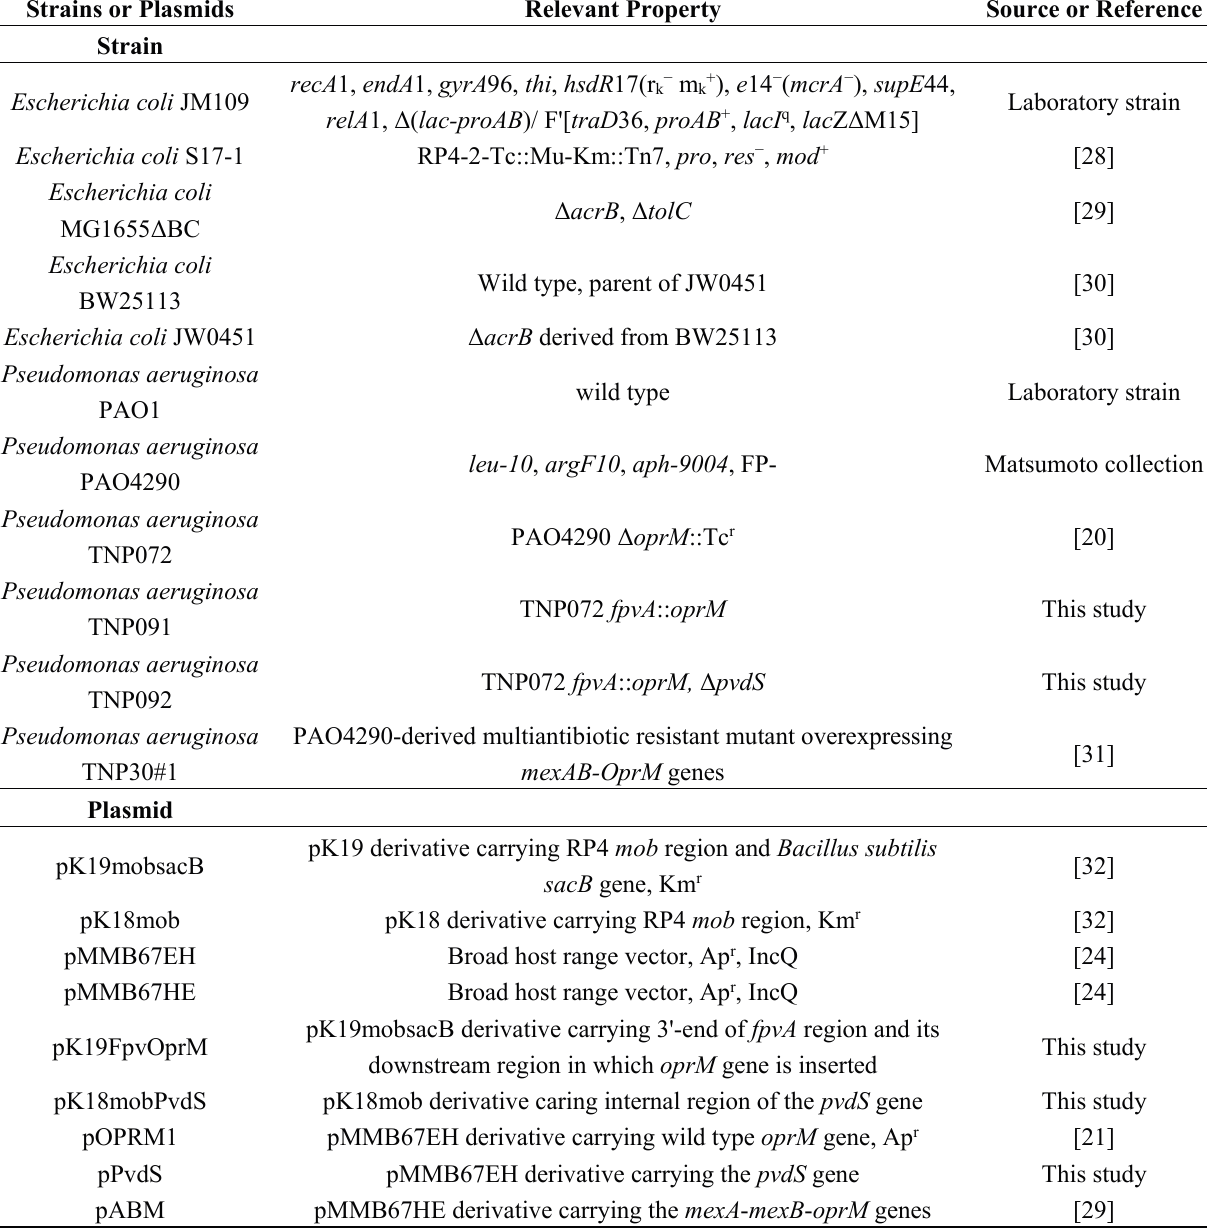
Table 2. Bacterial strains and